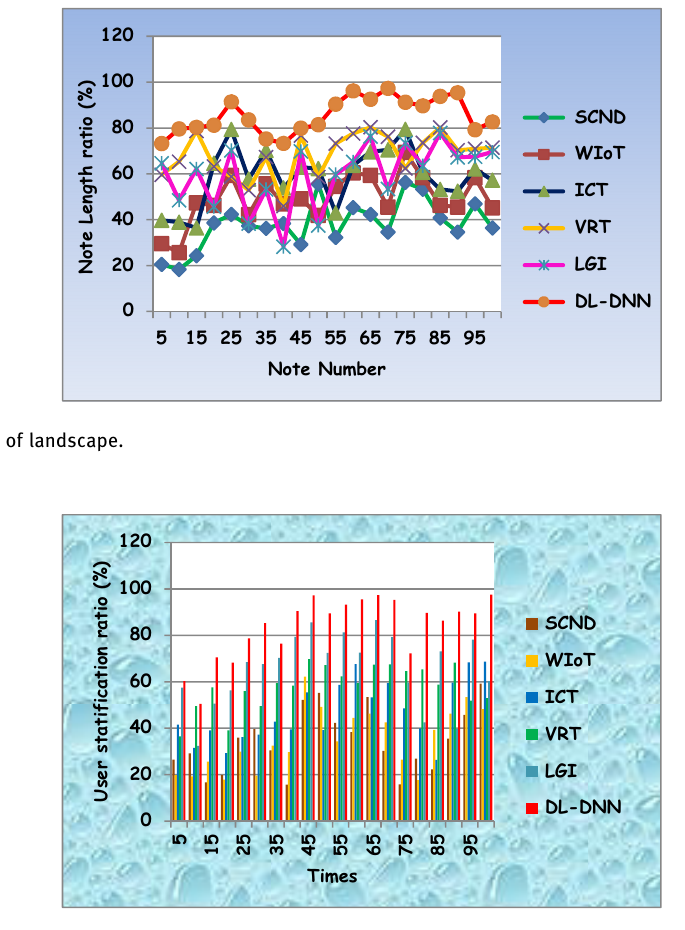
Figure 10: Rationality of